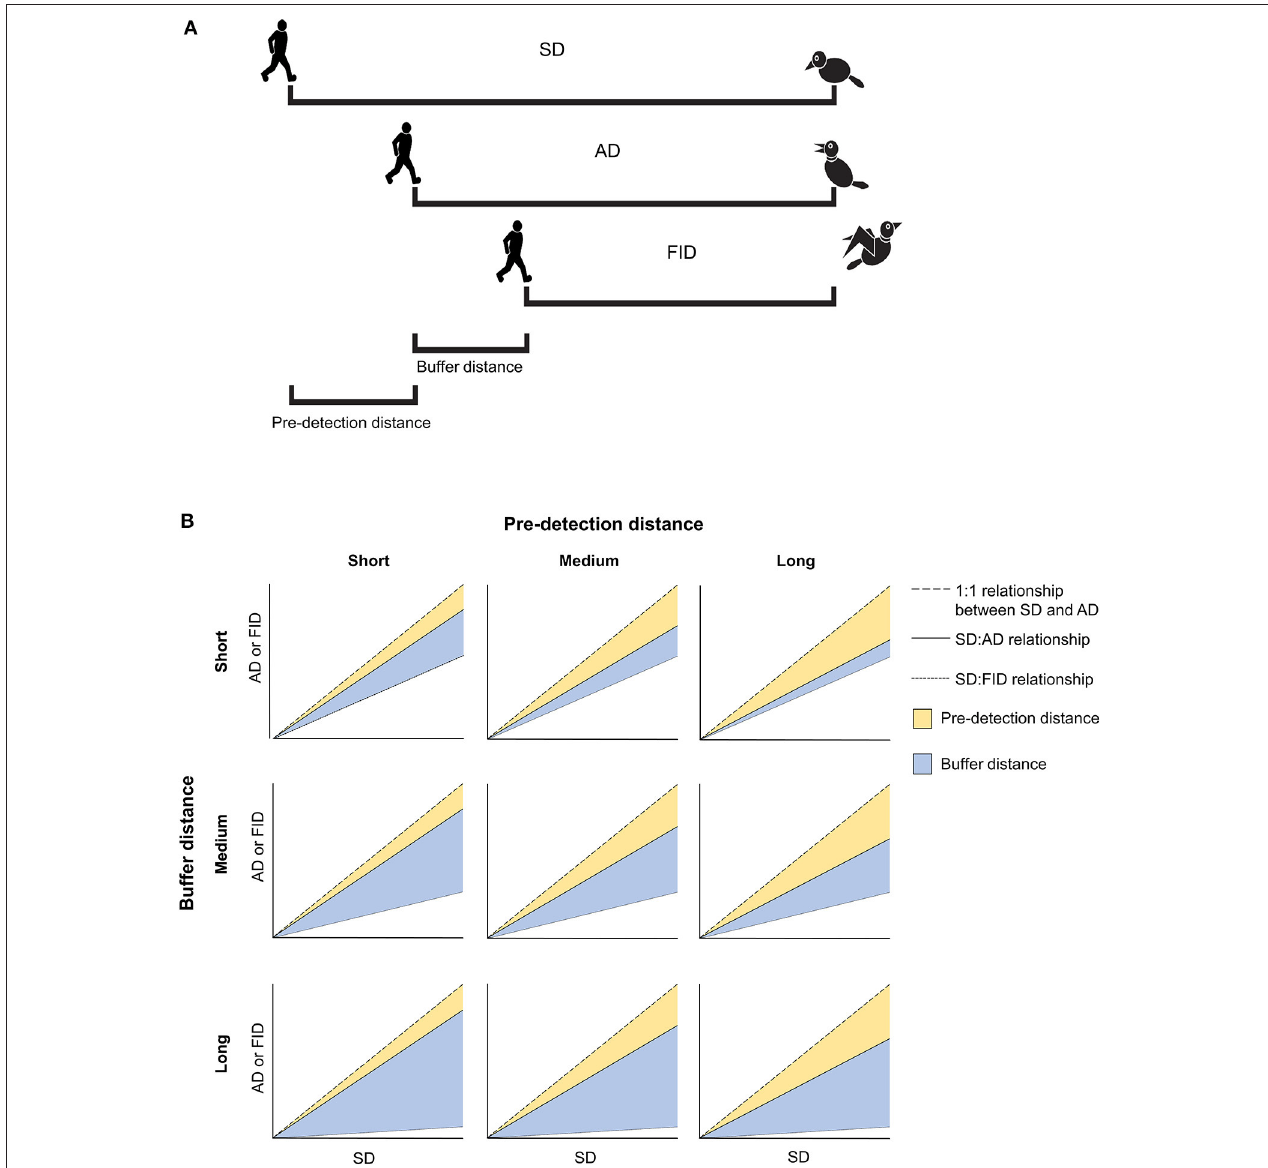
FIGURE 1 | (A) Illustration of the five anti-predator behaviors considered in the present study. Starting distance (SD) is measured as the distance at which an approaching human begins to approach a prey. Alert distance (AD) is measured as the distance at which prey responds by orienting toward the approaching human. Flight initiation distance (FID) is measured as the human-prey distance when the prey begins to flee. Pre-detection distance is a measure of how long a prey takes to become aware of an approaching human (i.e., the difference between SD and AD). Buffer distance is an estimate of tolerance calculated as the distance at which a prey fled after being alerted by an approaching human (i.e., the difference between AD and FID). (B) Some hypothetical relationships between SD, AD, and FID as a function of short, medium, or long pre-detection distances and short, medium, or long buffer